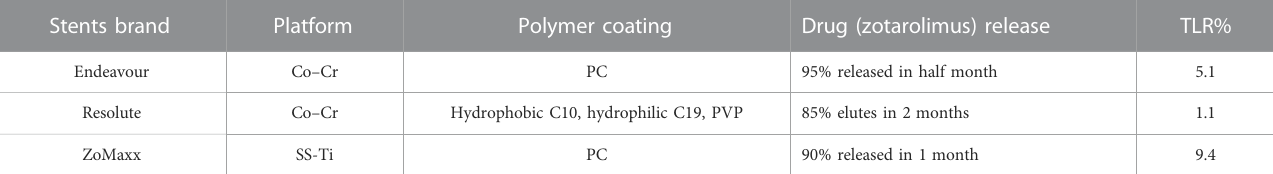
TABLE 5 Representative ZEs comparison.